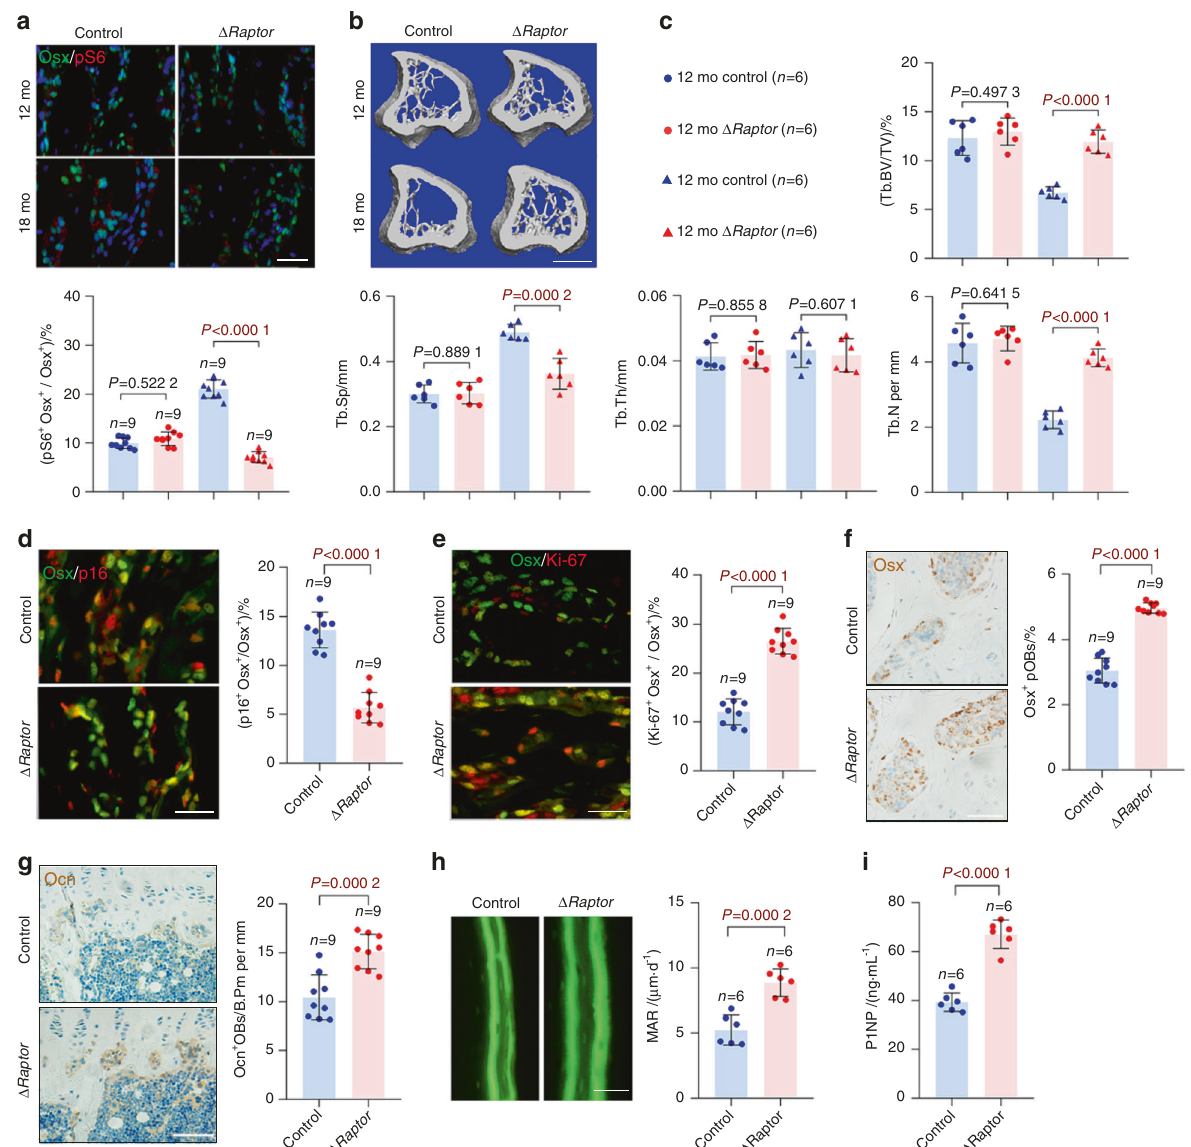
Fig. 3 mTORC1 inactivation alleviates preosteoblast senescence and bone loss. a Double immunostaining of Osx and pS6 and quanti fi cation of pS6 + preosteoblasts (pS6 + Osx + ) relative to total preosteoblasts (Osx + ) in the tibias of 12- and 18-month-old Δ Raptor mice. Scale bar, 100 μ m. Representative microcomputed tomography ( μ CT) images ( b ) and quanti fi cation of trabecular bone ( c ) in the 12- and 18-month-old Δ Raptor tibias compared with those from the littermate controls. Scale bar, 500 μ m. Double immunostaining of Osx plus p16 ( d ) and Osx plus Ki-67 ( e ) in tibias. Double positively stained cells were quanti fi ed. Scale bars, 100 μ m. IHC staining for Osx ( f ) and osteocalcin (Ocn) ( g ) in the tibias of the 18-month-old Δ Raptor mice and their littermate controls. Scale bar: 100 μ m. Osx-positive preosteoblasts (Osx + pOBs) were quanti fi ed as cell numbers per total cells in the bone marrow. Ocn-positive mature osteoblasts (Ocn + OBs) on the bone surface were measured as cells per millimeter of perimeter in the sections (/B.Pm). h Representative images of calcein labels and quanti fi cation of the mineral apposition rate (MAR) in femurs from the 18-month-old Δ Raptor mice and their littermate controls. Scale bar = 50 μ m. i Serum levels of P1NP in the 18-month-old Δ Raptor mice and their littermate controls determined by ELISAs. Data are shown as the mean ± SD. The numbers of samples ( n ) are indicated in each fi gure panel. P values were determined by two-tailed Student ’ s t test for single